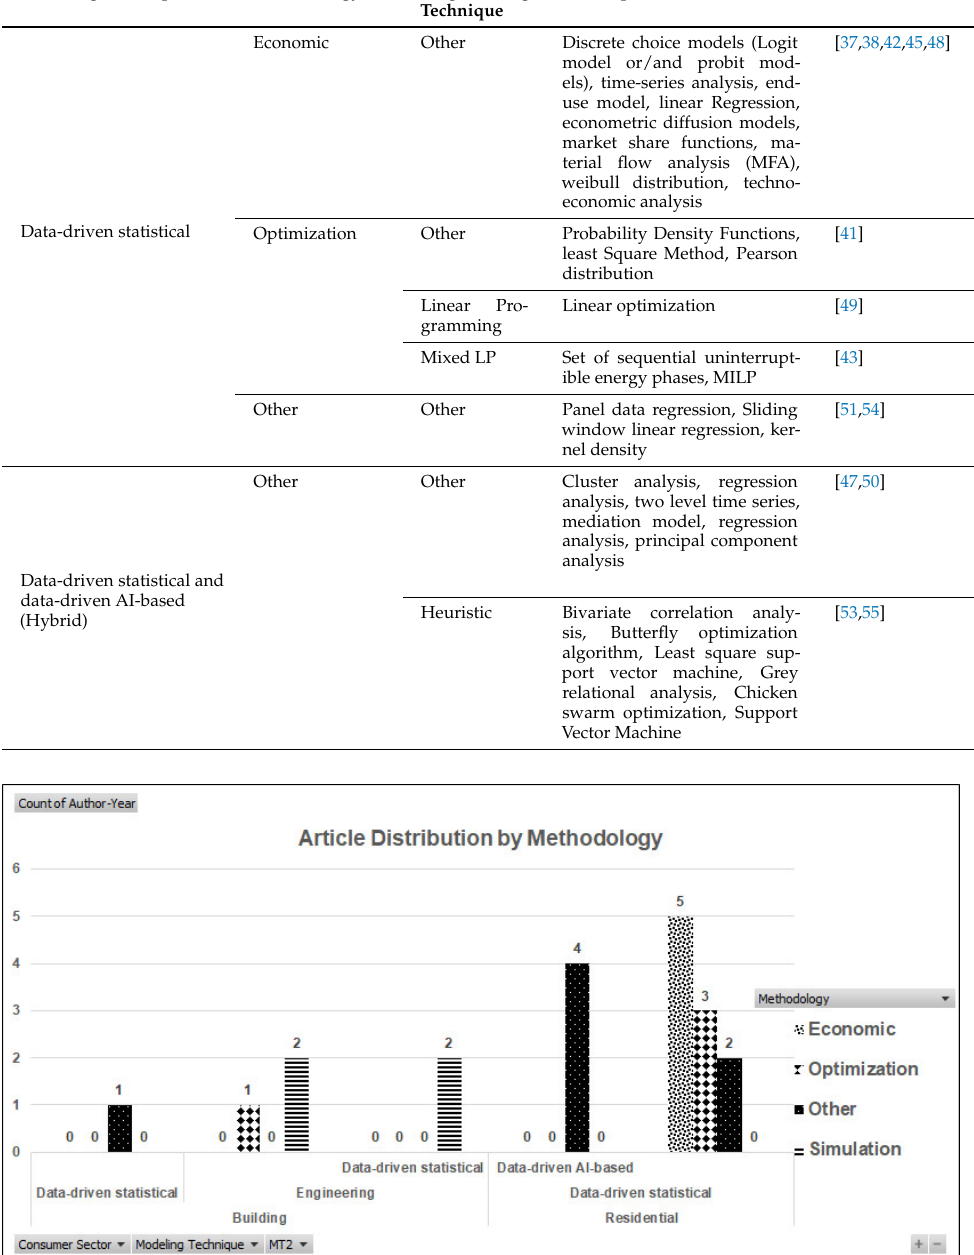
Figure 6. Distribution graph of number of articles by